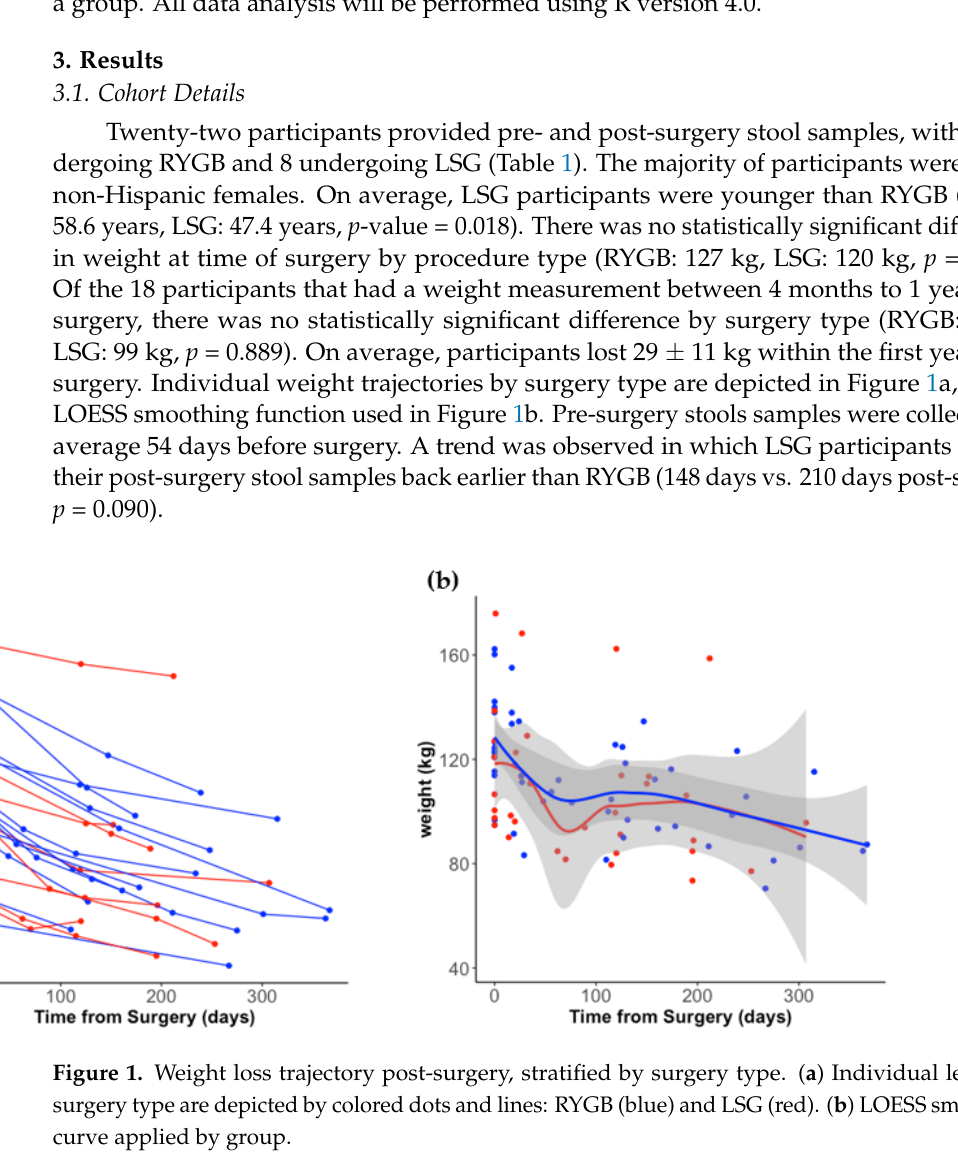
Figure 1. Weight loss trajectory post-surgery, stratified by surgery type. ( a ) Individual levels by surgery type are depicted by colored dots and lines: RYGB (blue) and LSG (red). ( b ) LOESS smoothing curve applied by group.